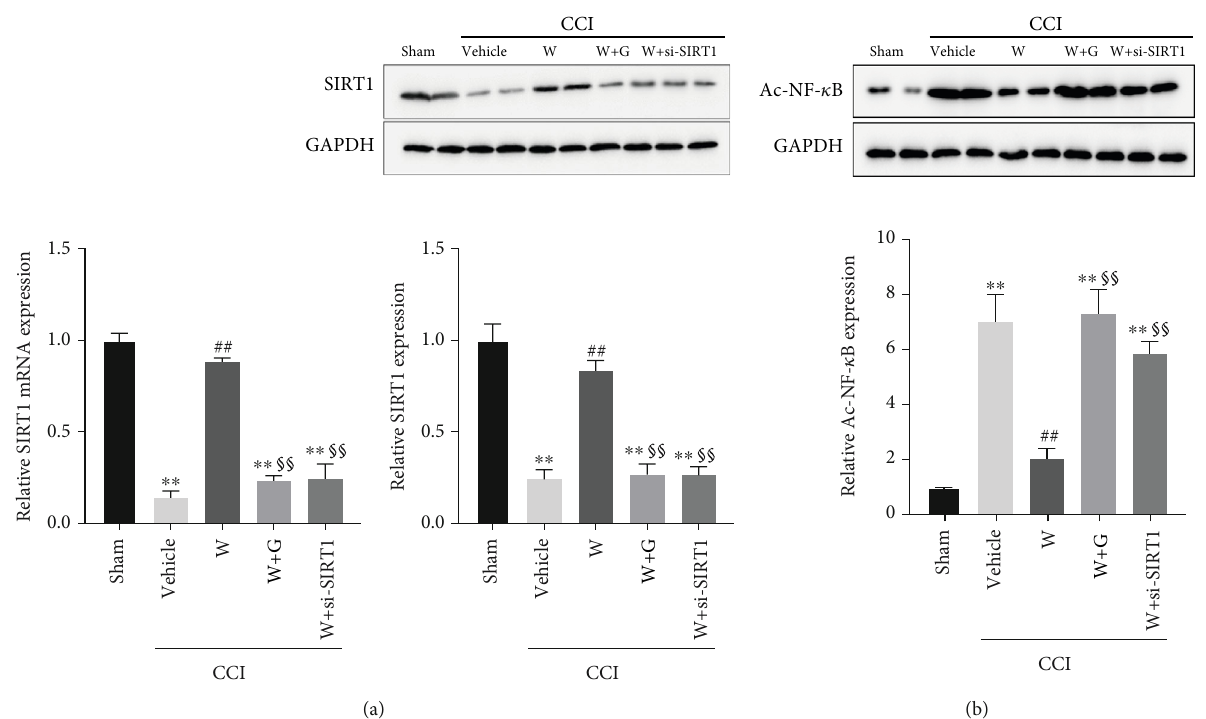
Figure 4: WY-14643 mediated the SIRT1/NF- κ B pathway by activating PPAR α . (a) The expression of SIRT1 in di ff erent groups was detected by qRT-PCR and western blot. WY-14643 administration increased SIRT1 expression. (b) The expression of acetylated NF- κ B p65 in di ff erent groups was detected by western blot. WY-14643 administration decreased acetylated NF- κ B p65 expression, but SIRT1 inhibition increased acetylated NF- κ B p65 expression. The relative protein expression was normalized according to the gray value of the band, which was analyzed by ImageJ.